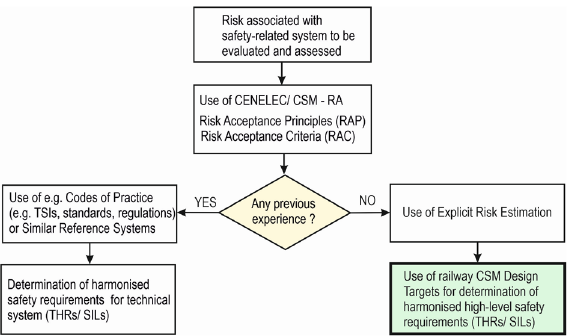
Figure 3. Flowchart for determination of harmonised high-level safety